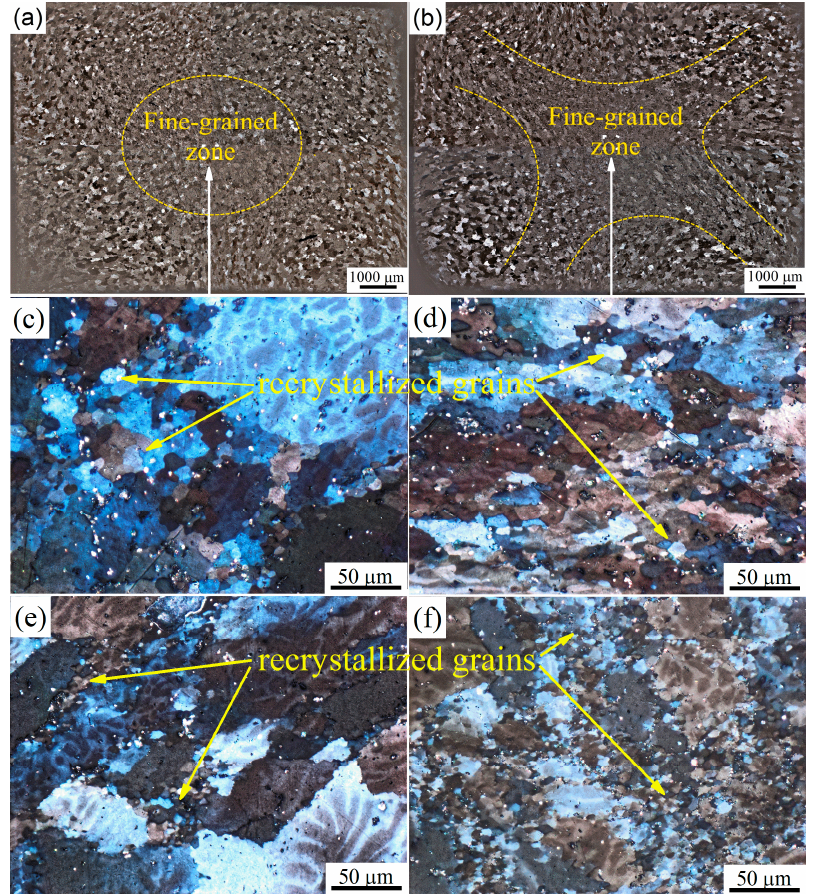
Figure 6. Structure of the median cross-section of the sample after ( a , c ) two ( ∑ e = 3) and ( b , d ) four ( ∑ e = 6) cycles at ( a – d ) 500 °C and ( e , f ) 400 °C.